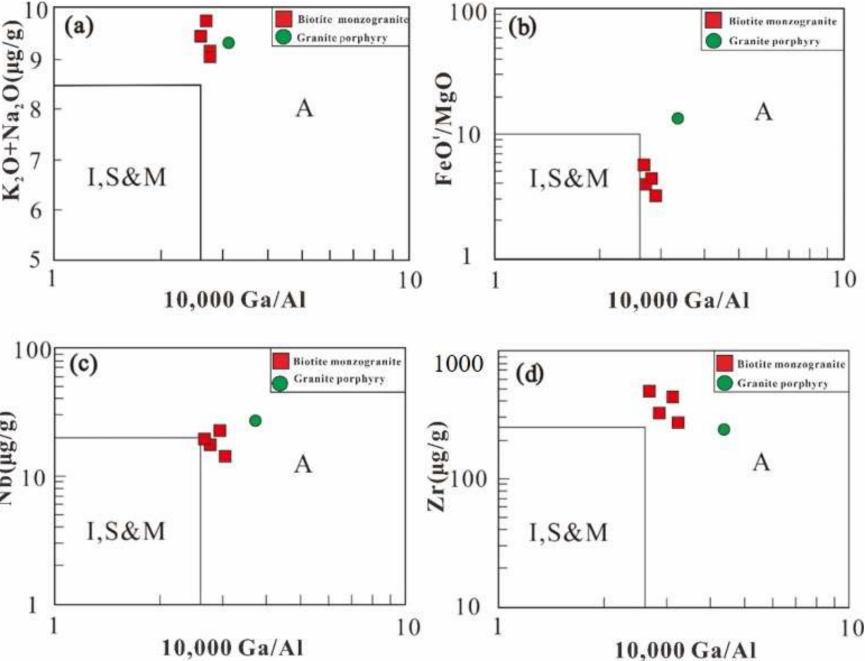
Figure 9. Plots of K 2 O + Na 2 O vs. 10,000 × Ga/Al ( a ), FeO t /MgO vs. 10,000 × Ga/Al ( b ), Nb vs. 10,000 × Ga/Al ( c ), Zr vs. 10,000 × Ga/Al ( d ) classification diagrams for the Nianzigou granite (after Whalen et al. [22]).